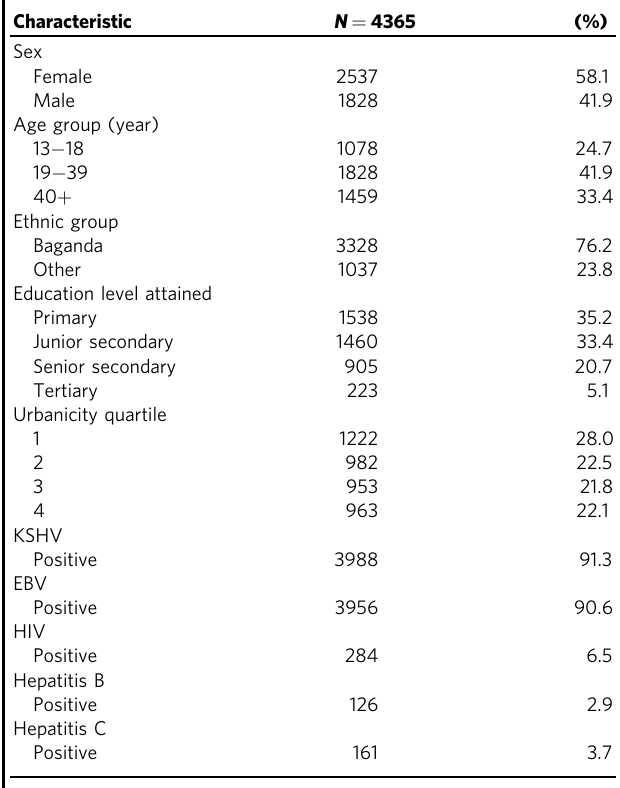
Table 1 Characteristics of individuals in the